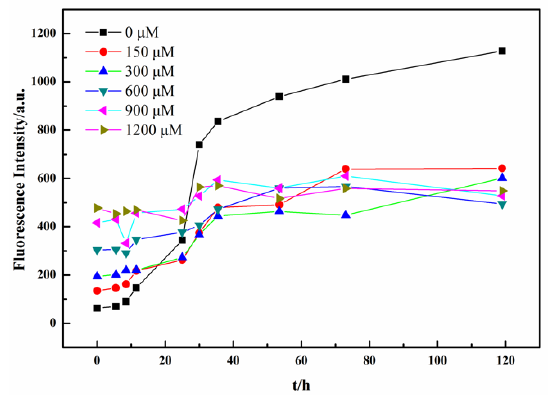
Figure 2. ThT fluorescence assay for the fibrillation kinetics of lysozyme.